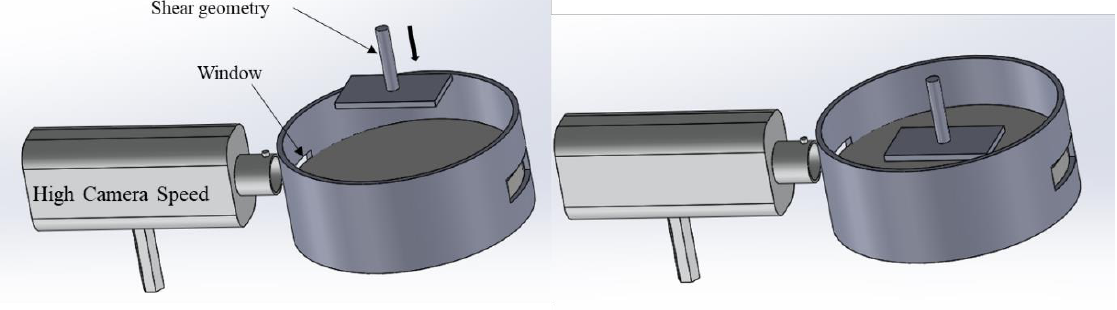
Figure 6. Positioning of the object at the interface using a visualization system. Reprinted from Ref. [35]. Copyright 2022 Copyright Clearance